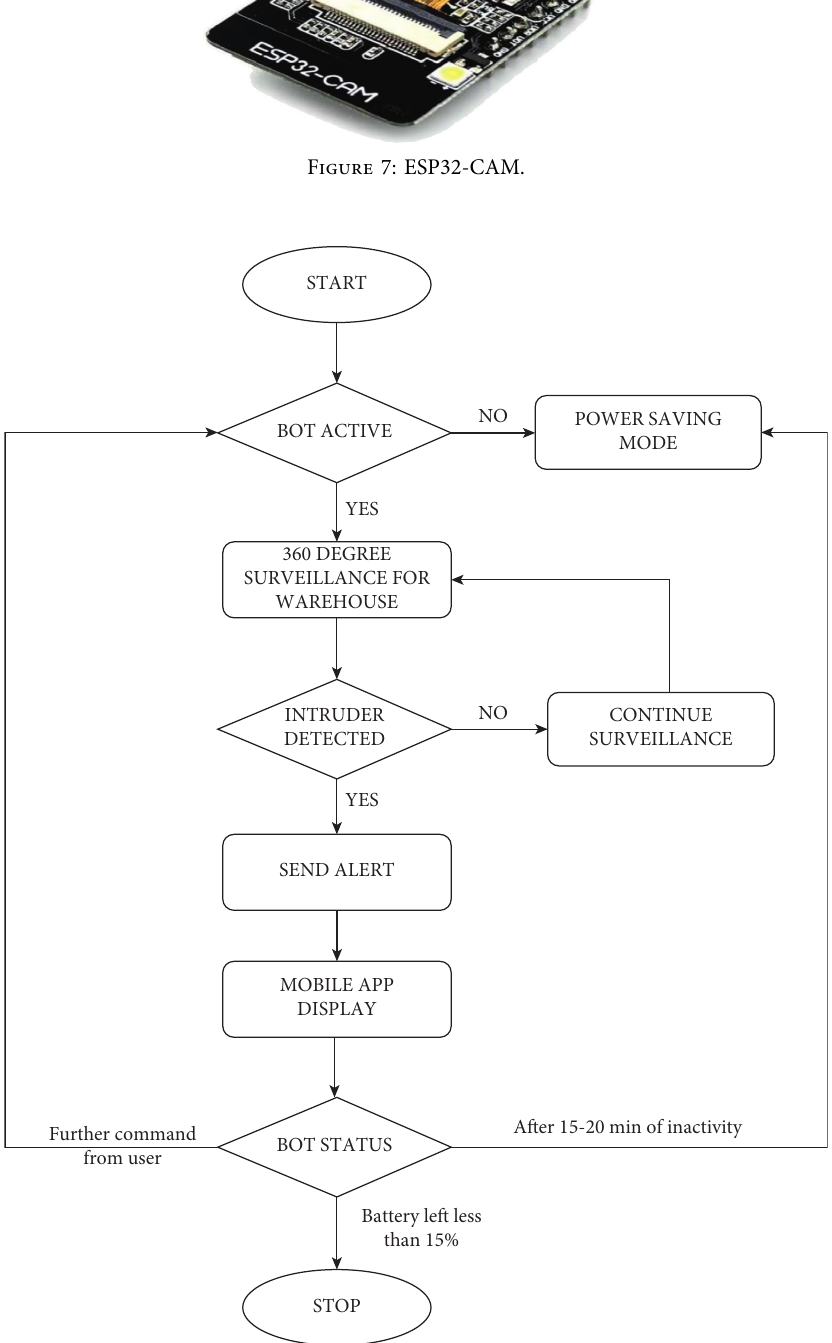
Figure 8: Flowchart of intruder detection using the